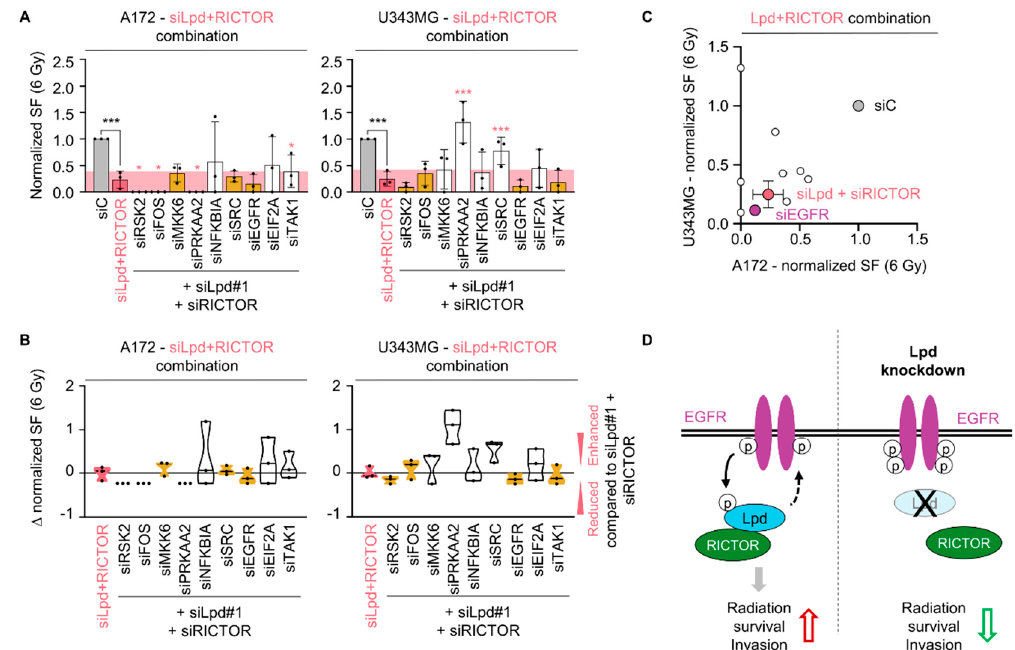
Figure 7. Lamellipodin and RICTOR jointly promote glioblastoma radiation survival via EGFR. ( A ) Normalized clonogenic radiation survival at 6 Gy of A172 and U343MG cells upon siRNA-specific triple knockdown of Lamellipodin, RICTOR and indicated proteins. Yellow columns indicate a surviving fraction comparable to double Lpd and RICTOR knockdown, whereas white columns indicate a differing survival. The pink area represents the normalized surviving fraction upon 6 Gy and Lpd and RICTOR silencing. ( B ) Differences in radiosensitizing effects shown by ∆ values of normalized surviving fraction 6 Gy upon knockdown of the indicated proteins subtracted by double Lpd and RICTOR knockdown in A172 and U343MG cells. ∆ value is defined as survival compared to the survival of siLpd and siRICTOR and 6 Gy treated cells: <0 reduced survival, 0 equal survival, >0 increased survival. Yellow color illustrates survival at 6 Gy comparable to Lpd and RICTOR knockdown, whereas white color demonstrates a distinct survival. All results are presented as mean ± SD ( n = 3, two-sided Student’s t- test, siLpd + siRICTOR/siC *** p < 0.001, siRNA/siLpd + siRICTOR * p < 0.05, ** p < 0.01, *** p < 0.001). ( C ) Normalized surviving fraction at 6 Gy of A172 and U343MG shown in ( A ). ( D ) Graphical scheme summarizing the interaction of Lamellipodin with RICTOR and the regulation of radiosensitivity and invasion in glioblastoma cells through interplay with the EGFR signaling hub. EGFR exerts a positive effect on Lpd phosphorylation. Conversely, Lpd negatively regulates EGFR levels and phosphorylation. This interplay is cell-line-dependent and may be modulated by basal EGFR activity. Lpd further binds to RICTOR facilitating survival and invasion. Lpd silencing dysregulates EGFR phosphorylation, renders sensitivity to X-rays and reduces invasion. si, small interfering RNA; SF, surviving